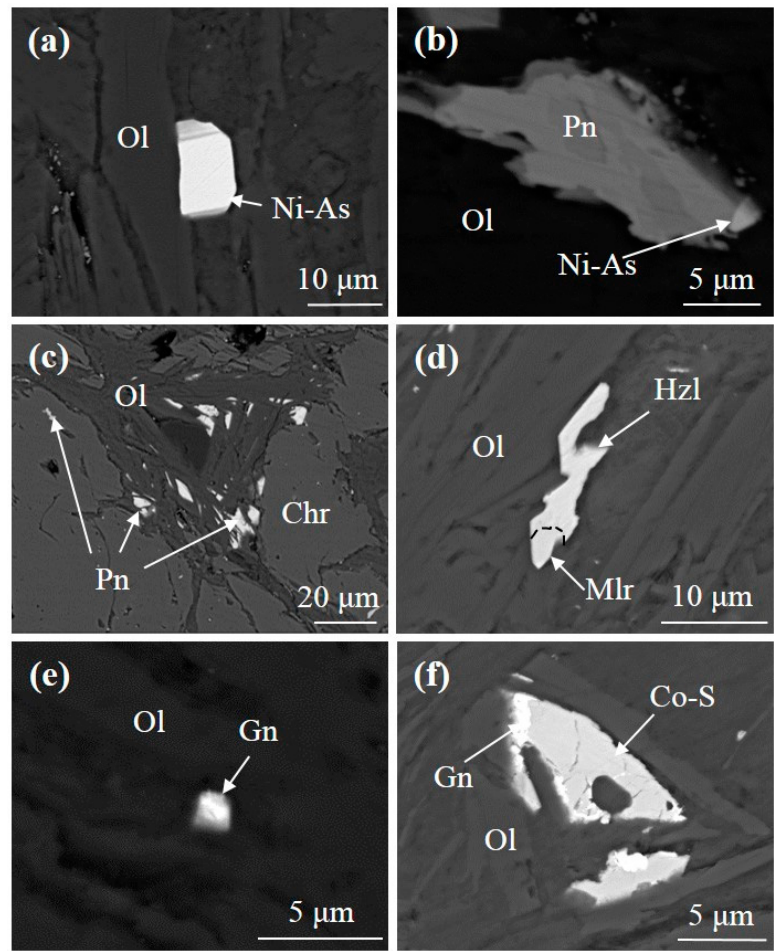
Figure 7. BSE images of base-metal minerals in serpentinized olivine. ( a ) Euhedral maucherite occurring as a single mineral phase; ( b ) pentlandites associated with maucherite; ( c ) pentlandites occurring as a single mineral phase; ( d ) heazlewoodite associated with millerite; ( e ) galena occurring as a single mineral phase; ( f ) galena occurring at the boundary of jaipurite. Ol: olivine; Mlr: millerite; Co–S: cobaltous sulfide.